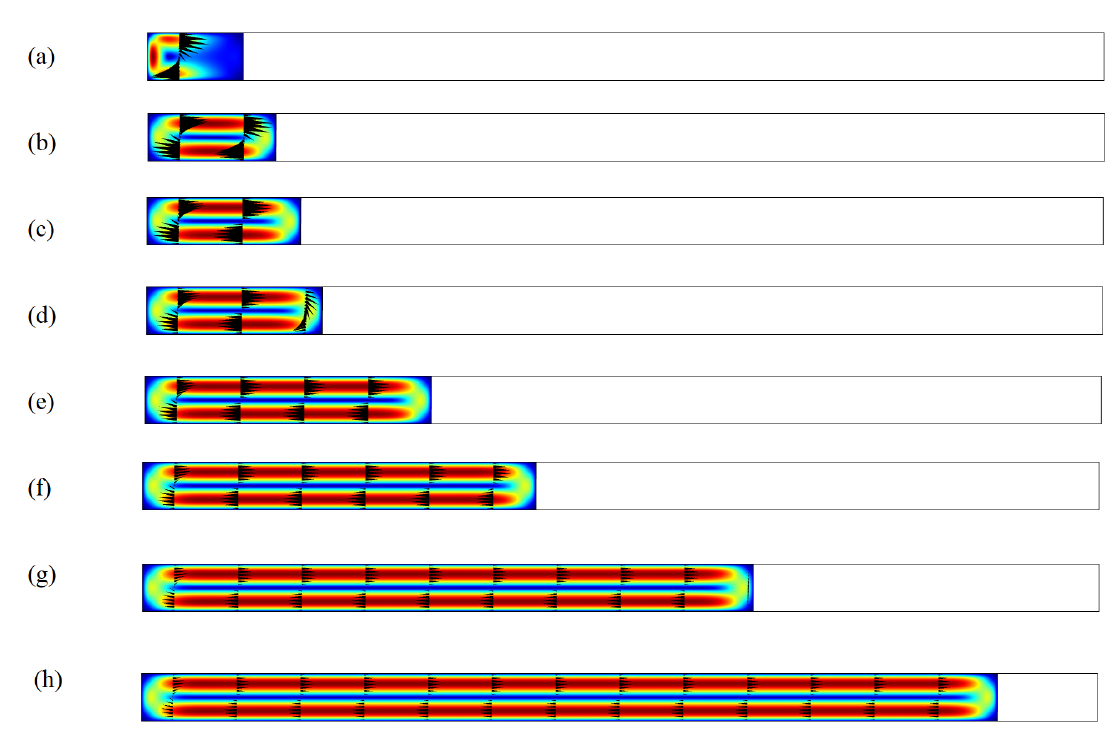
Figure 21. Profile development and contours of velocity magnitude in liquid part of PCM cell ( a ) t = 10, ( b ) t = 100, ( c ) t = 200,